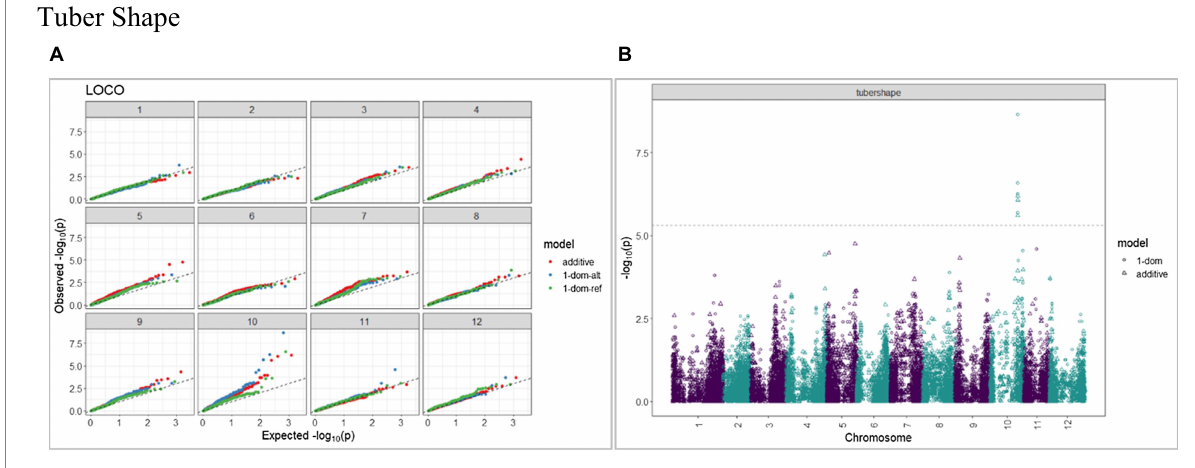
FIGURE 4 Q–Q plots of observed vs. expected − log10 ( p values) ( A ) and corresponding Manhattan plot (B) for tuber shape using additive and dominant models. GWAS was based on 214 potato clones evaluated for tuber traits of 214 potato clones evaluated in three environments in Texas: Dalhart 2019, 2020, and Springlake 2020. The Bonferroni threshold was at 5.3 for the additive, 5.0 for 1-dom-alt, and 5.1 for the 1-dom-ref model.